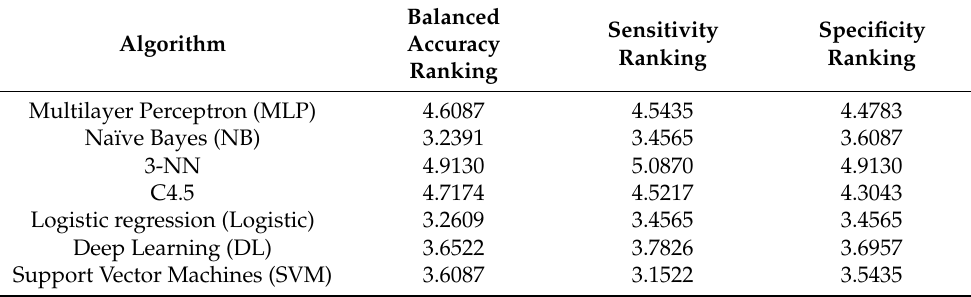
Table 7. Ranking obtained by the Friedman test. Algorithm